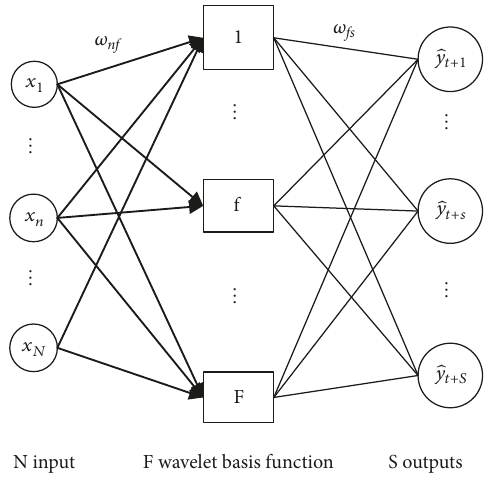
Figure 3: Structure of the wavelet neural network for lower